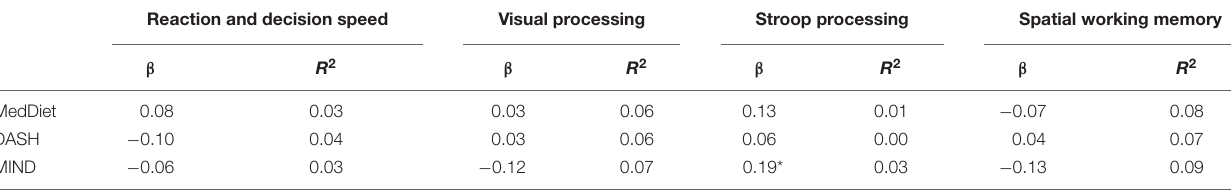
TABLE 4 | Association of diet scores with cognitive performance, standardized coefficients beta, and adjusted R -Square. Reaction and decision speed Visual processing Stroop processing Spatial working memory